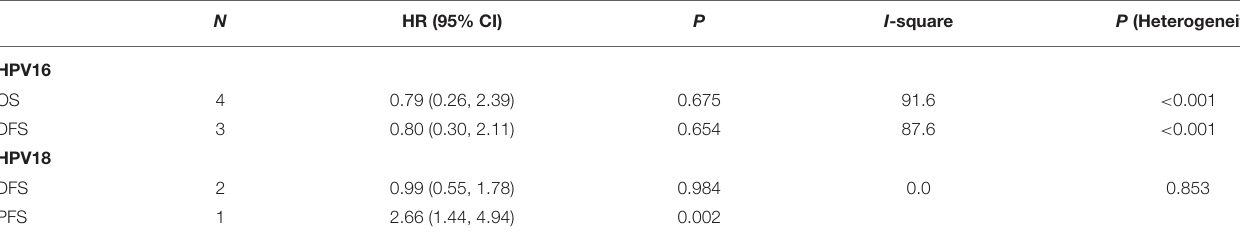
0.79 (0.26, 2.39) 0.675 91.6 < 0.001 87.6 <